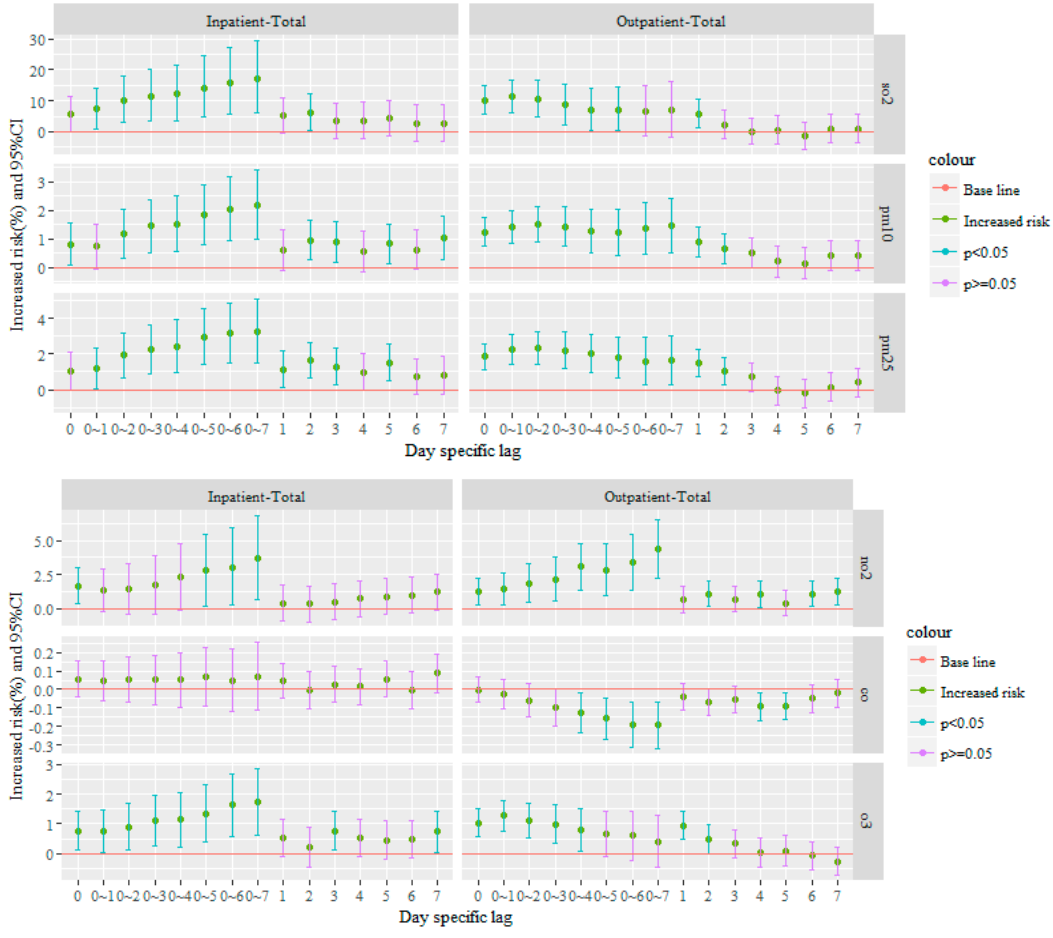
Figure 1. Increased risk estimates and 95% CI between each pollutant and overall outpatient and inpatient visits under different day specific lag associated with a 10 μ g/m 3 increase in air pollutants.